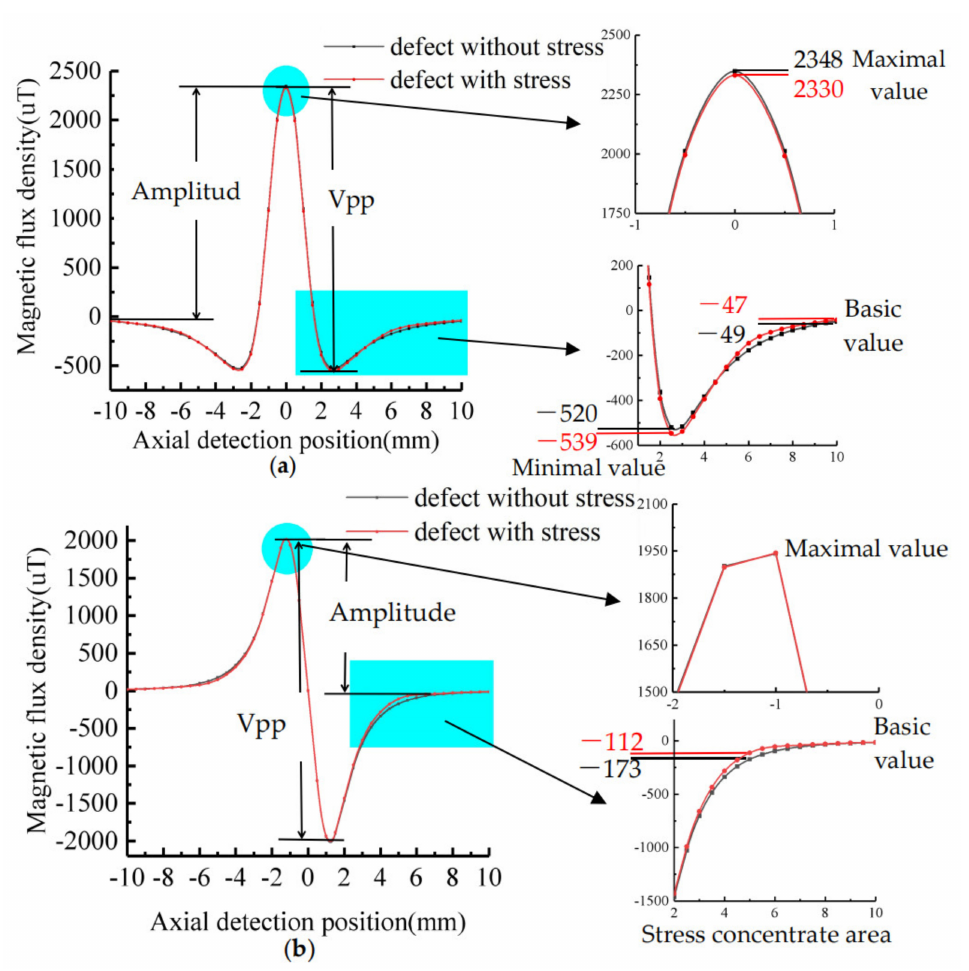
Figure 7. Comparison of quantitative calculation of MFL: ( a ) Tangential signal; ( b ) Normal signal.